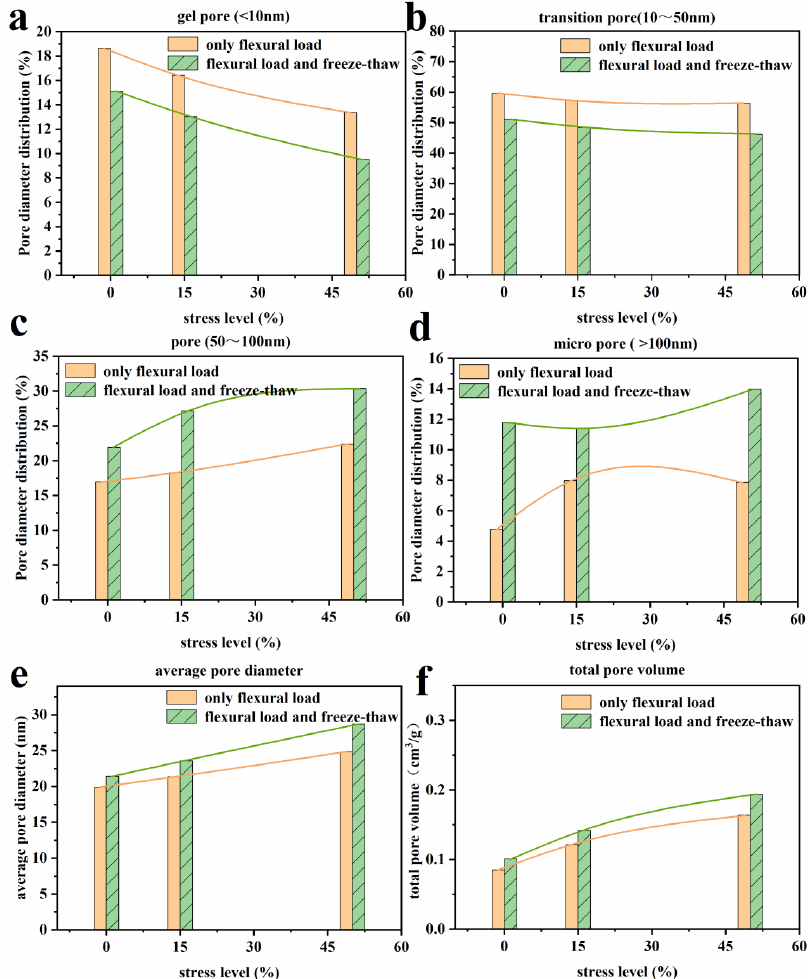
Figure 5. Comparative analysis diagram of only the bending load and bending load-freeze – thaw interaction hole structure. ( a ) gel pore, ( b ) transition pore, ( c ) pore, ( d ) micor pore, ( e ) average pore ammeterer, ( f ) total pore volume.